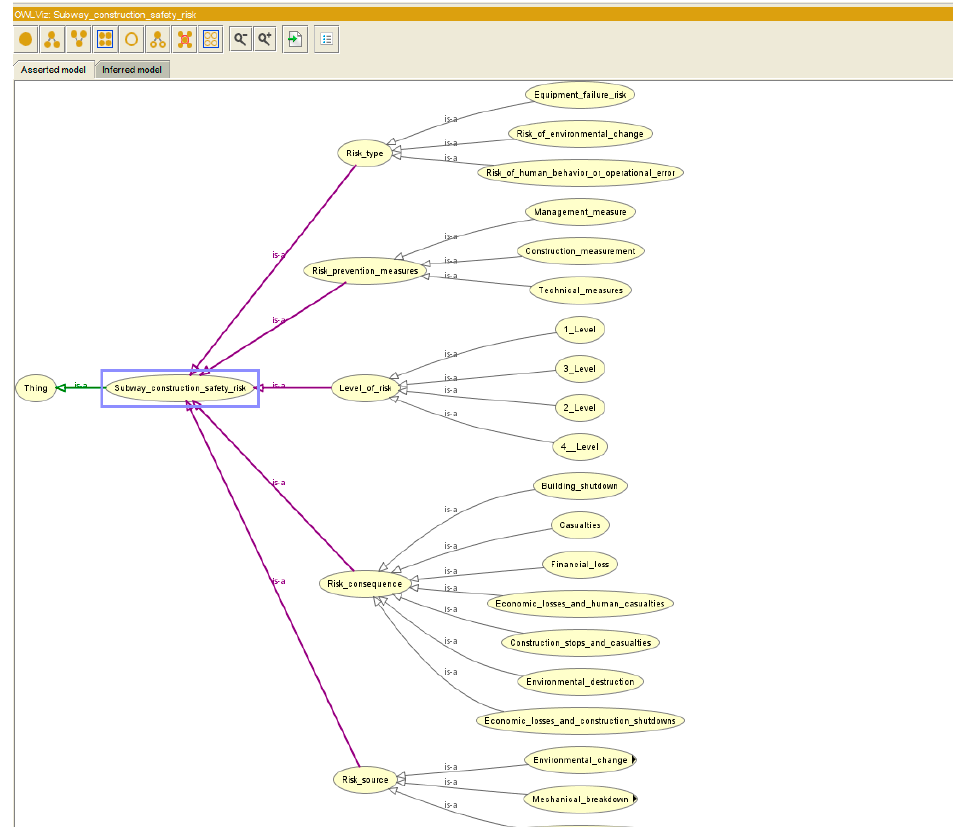
Figure 7. Subway construction safety ontology (section).